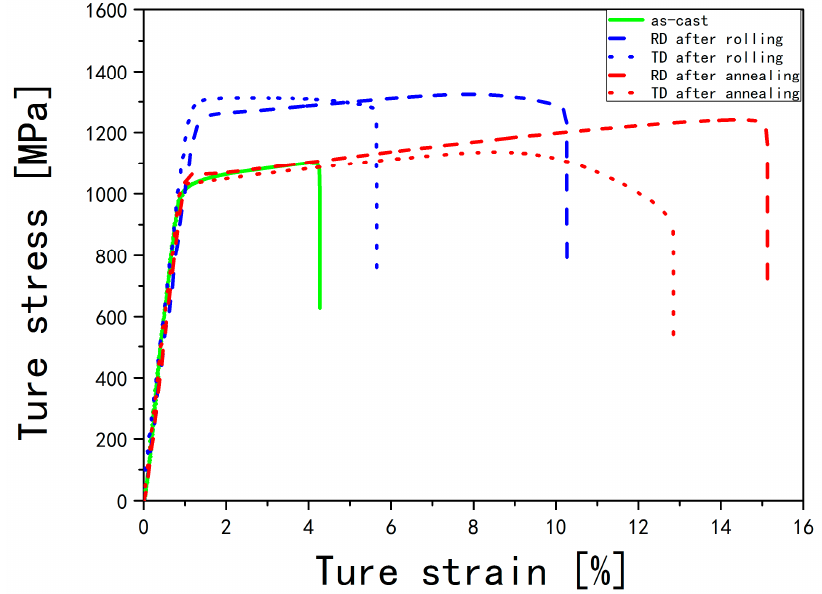
Figure 11. True stress-strain curves for β 20C alloys at a strain rate of 10 − 3 /s in the RD and the TD.